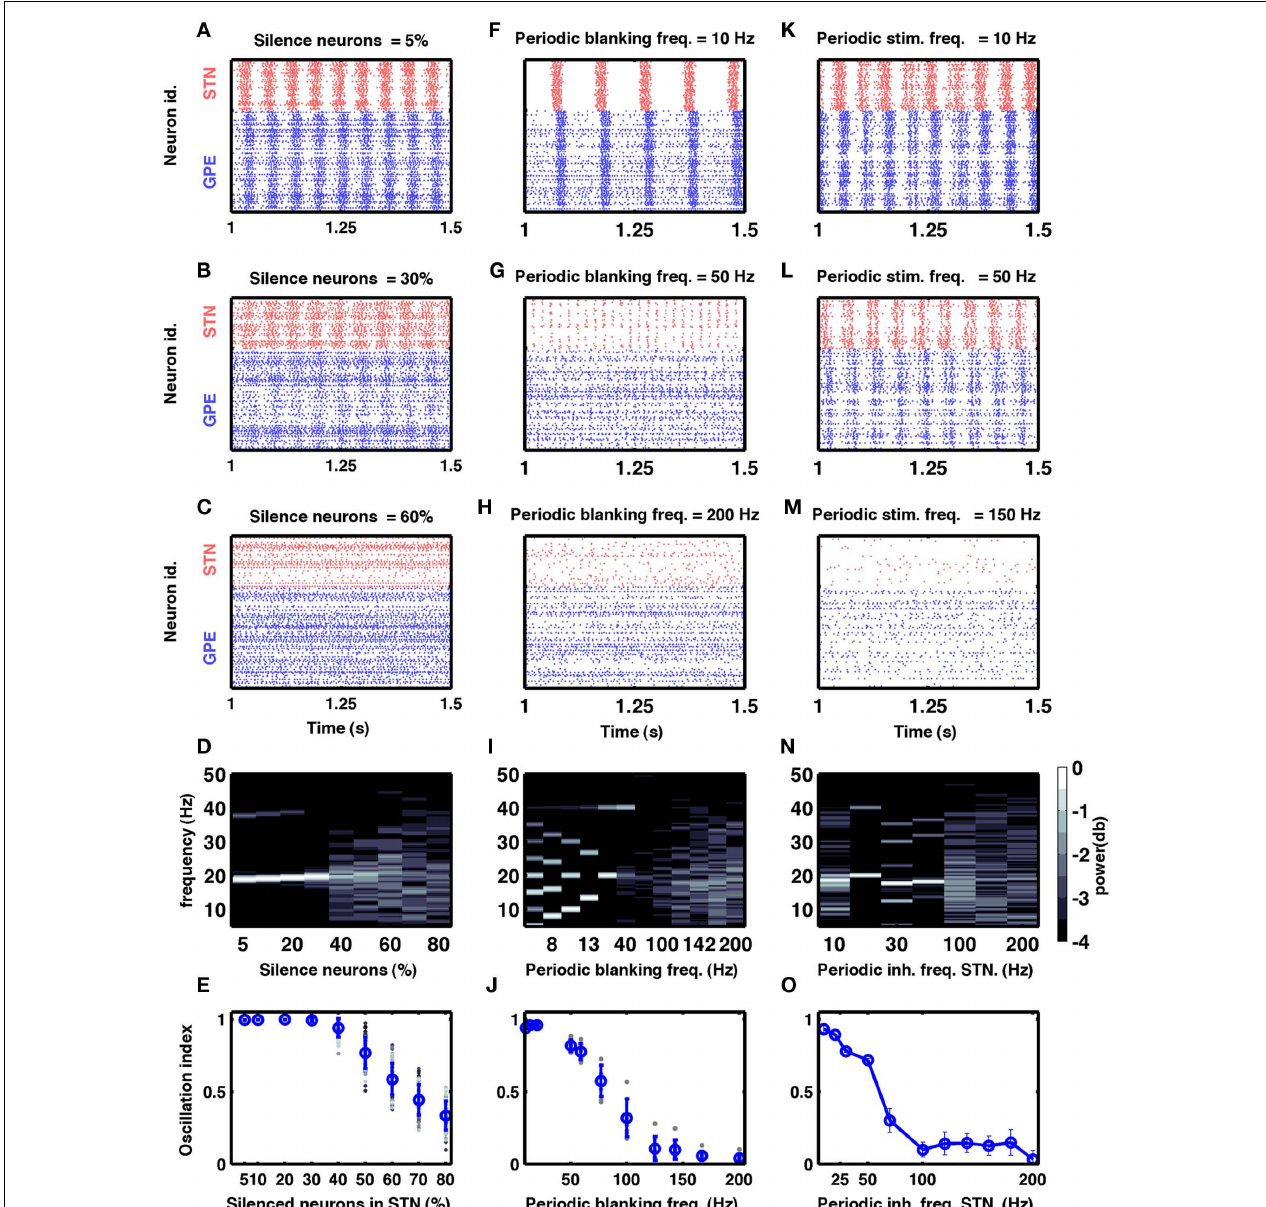
blanked at frequencies indicated above the respective plots. (I) Spectrum of the STN population activity as a function of the frequency at which the excitatory inputs to STN neurons were blanked. (J) Oscillation index in the STN, as a function of the frequency of periodic blanking of the excitatory inputs to STN neurons. Observe that only blanking frequencies above 100Hz were effective in reducing the network oscillations. (K–O) Effect of periodic inhibition of excitatory afferents to the STN neurons on the oscillations in the STN-GPe network. (K–M) Three examples of spiking activity of STN neurons when periodic inhibitory spiking activity was injected into the STN neurons at frequencies indicated above the respective plots. (N) Spectrum of the STN population activity as a function of the frequency of periodic inhibitory input to the STN neurons. (O) Oscillation index in the STN, as a function of the frequency of periodic inhibitory stimulation of STN